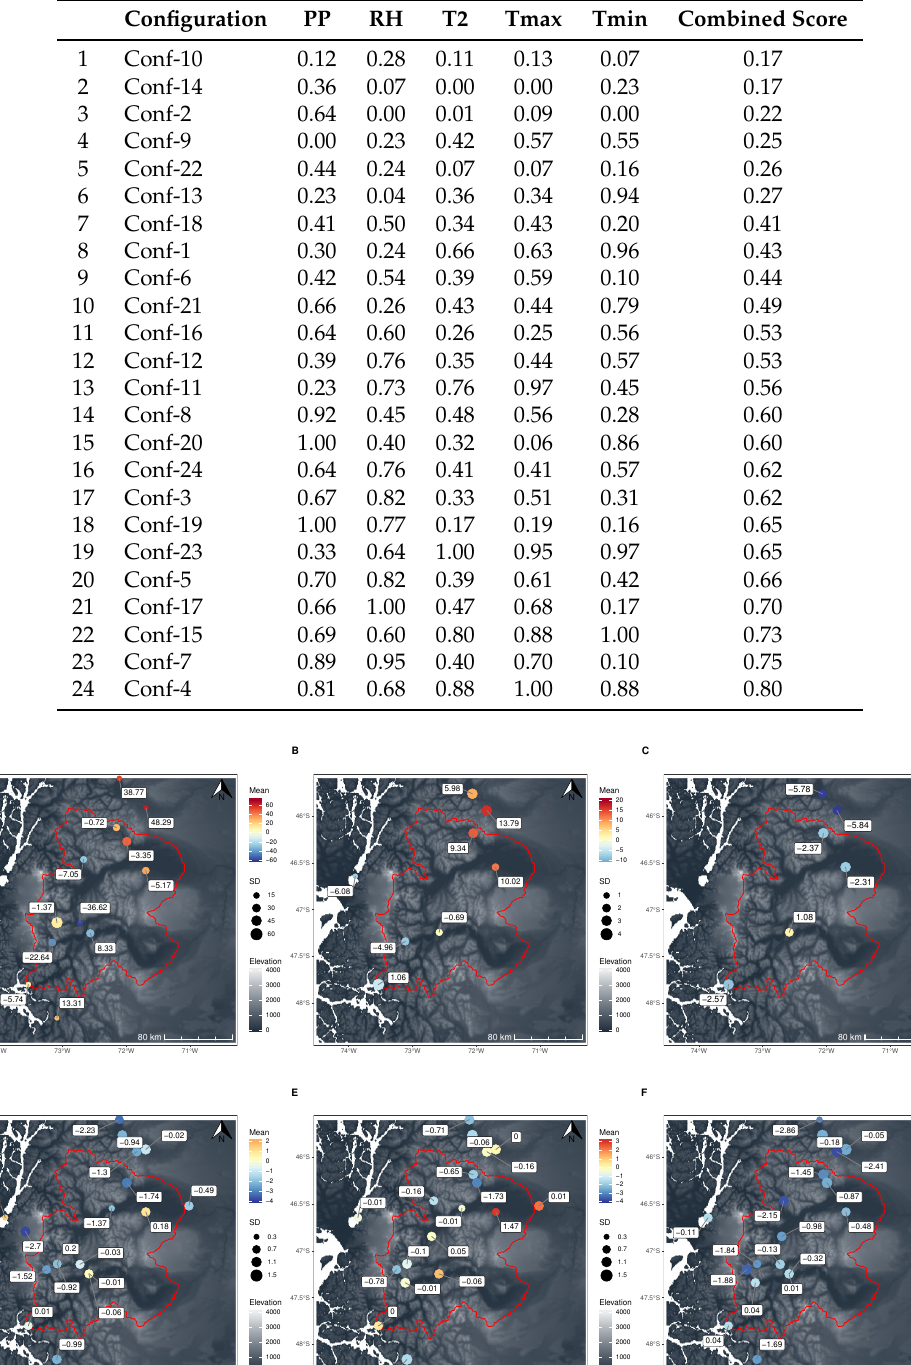
Table 4. Scores obtained for each variable and the total. The lower the value, the better the performance of the configuration according to the NSE, PCBIAS, and RSR statistics.